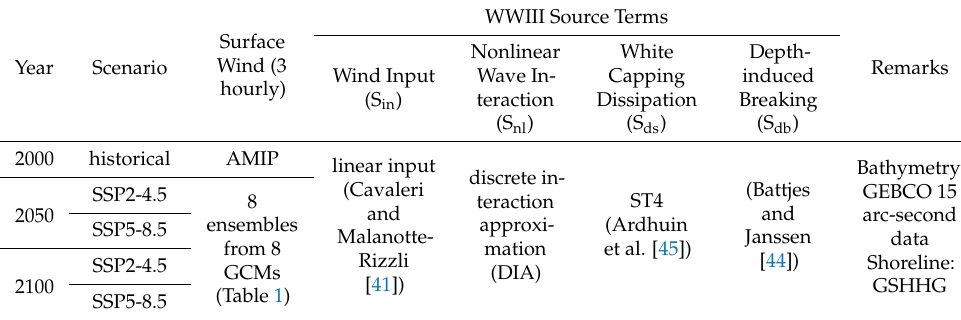
Table 2. Summary of numerical experiments with model setups and surface